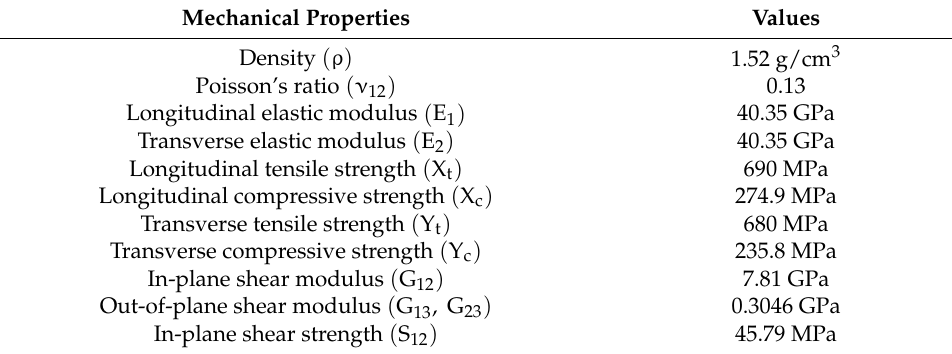
Table 5. Mechanical properties of CFRTP [27].